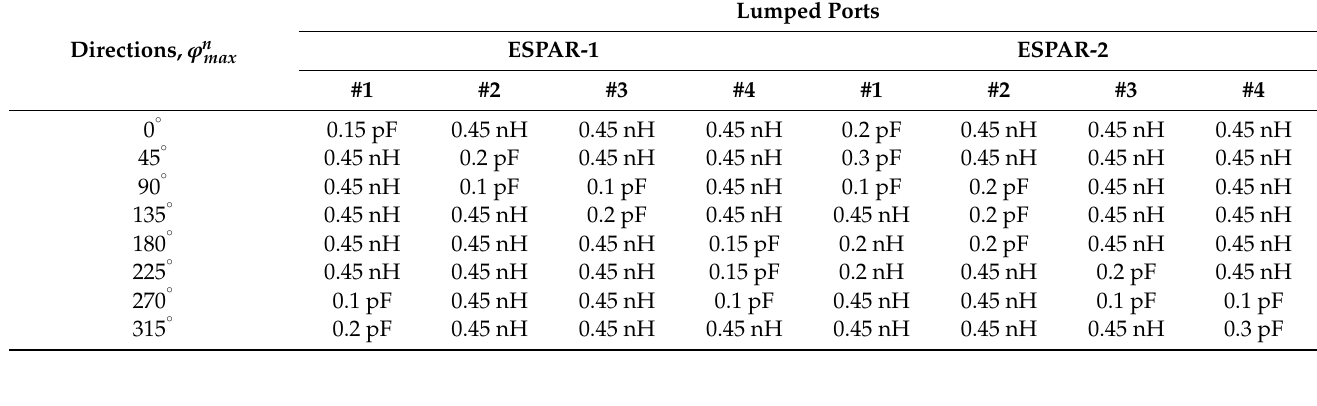
Figure 7. ( a ) Reflection coefficients of S1,1 and S2,2; ( b ) complete reflection coefficient during 𝜑 (cid:3040)(cid:3028)(cid:3051)(cid:2874) = 225 (cid:2868) ; ( c ) reflection coefficient after far-field combination. Table 4. Reactance set of the proposed 1 × 2 ESPAR array antenna.